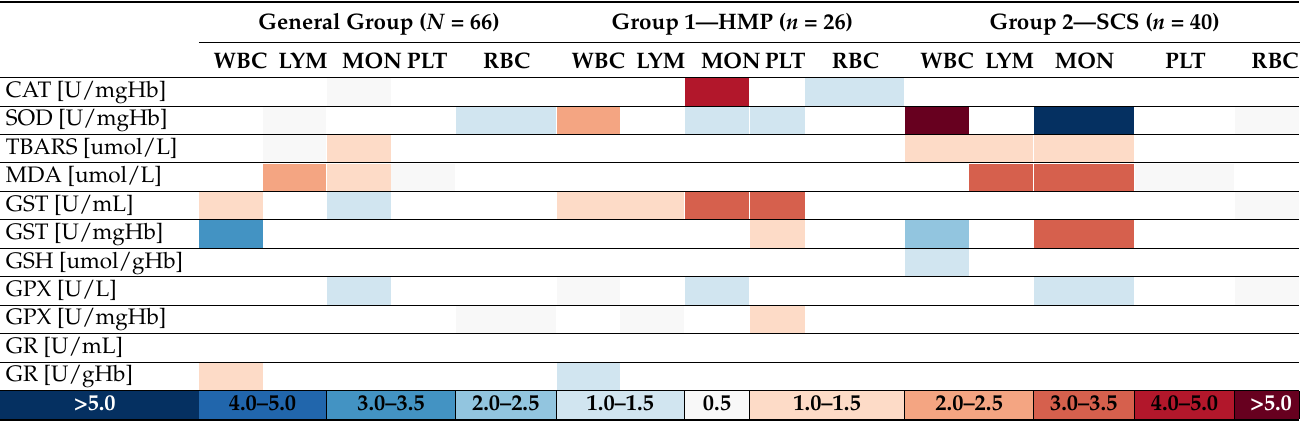
Table 7. Heatmap of matrix correlations between oxidative stress biomarkers and blood count in repeated measurements (WBC—white blood cell count, LYM—lymphocytes count, MON—monocytes count, PLT—platelets count, RBC—red blood cell count) with aggregation intensity color